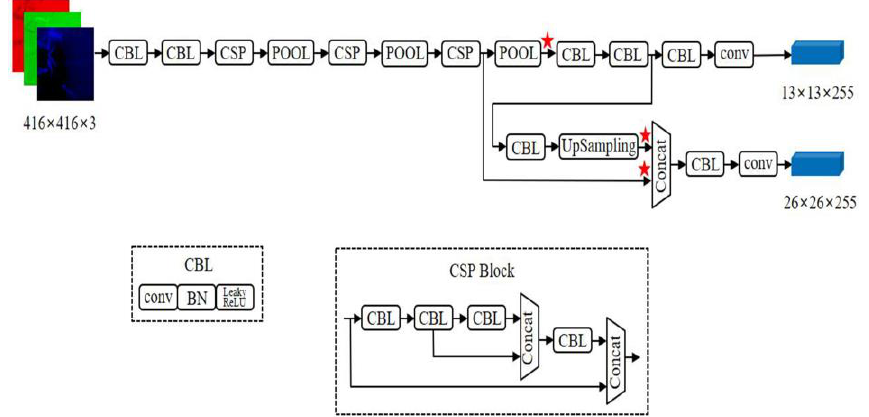
Figure 13. Structure of YOLOv4-Tiny model with attention mechanism added. Table 3. Comparing network detection results.